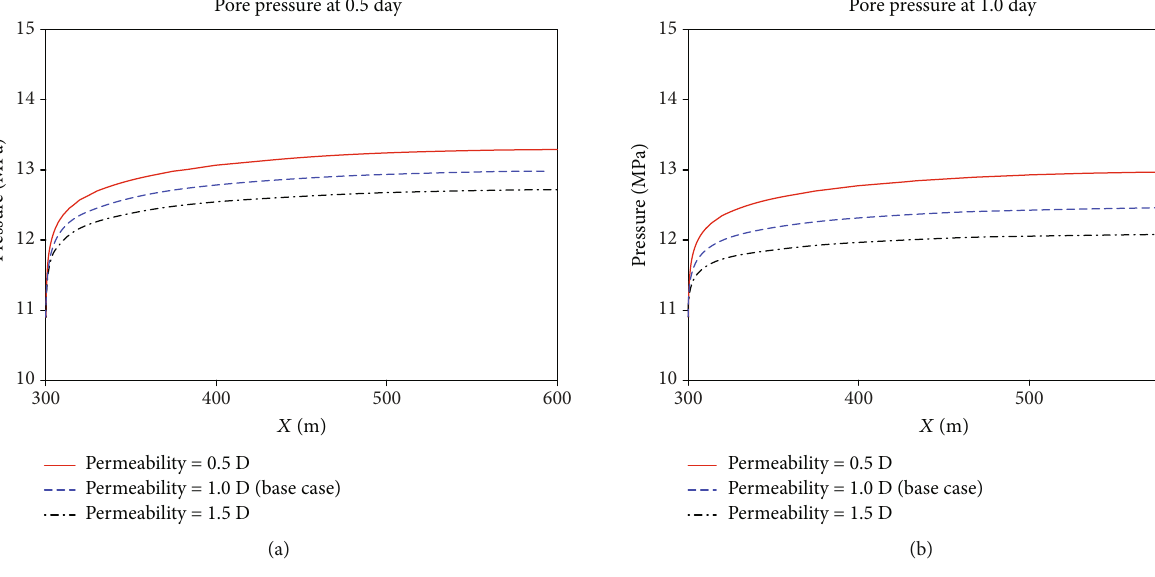
Figure 9: 1D pressure distribution from the wellbore to the domain boundary along Y = 300 m after (a) 0.5 day and (b) 1 day of shallow water fl ow for permeability